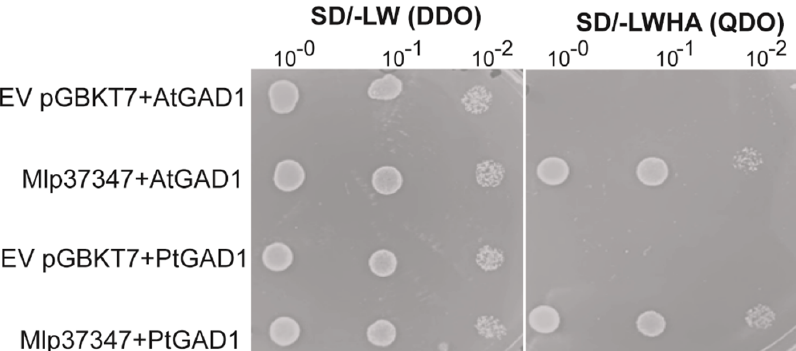
Figure 3. Mlp37347 interacts with AtGAD1 and PtGAD1. Co-expression of AtGAD1/PtGAD1 with Mlp37347 in yeast shows interaction between GAD1 and Mlp37347. Yeast co-expressing the indicated combination of bait and prey were spotted on the synthetic double dropout medium lacking leucine and tryptophan (SD/-LW (DDO)) and quadruple dropout medium lacking leucine, tryptophan, histidine, and adenine (SD/-LWHA (QDO)). The plates were photographed 3–4 days after inoculation. To further characterize this interaction, the structure models of Mlp37347 and Popu- lus trichocarpa GAD1 (PtGAD1) were constructed by I-TASSER. The predicted models